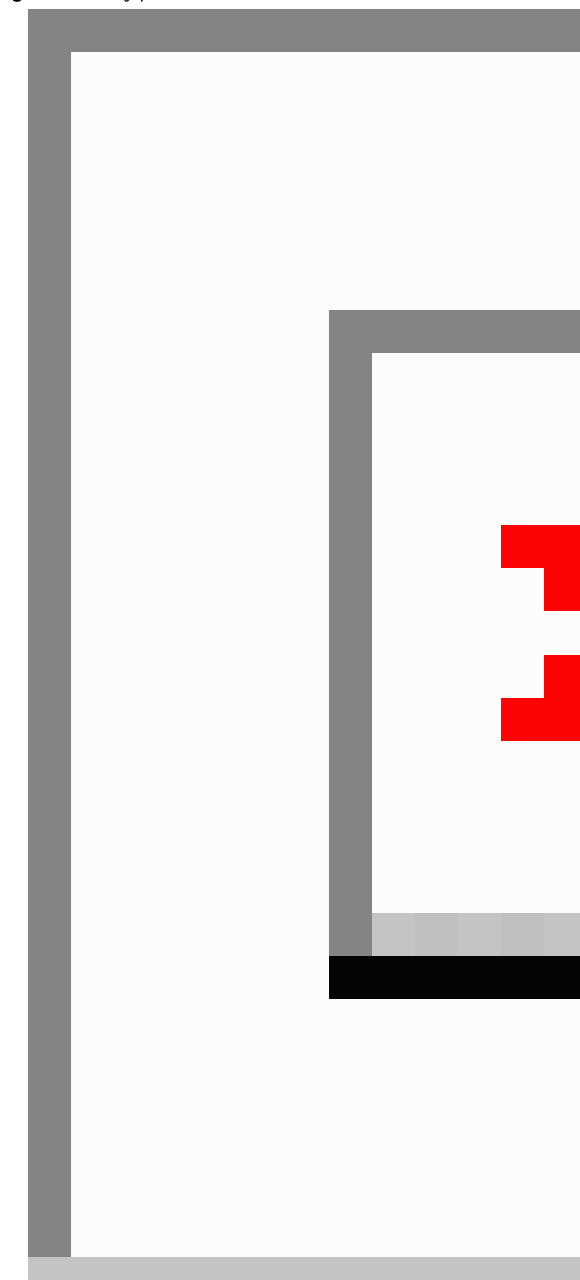
Figure 1. Study procedures flow